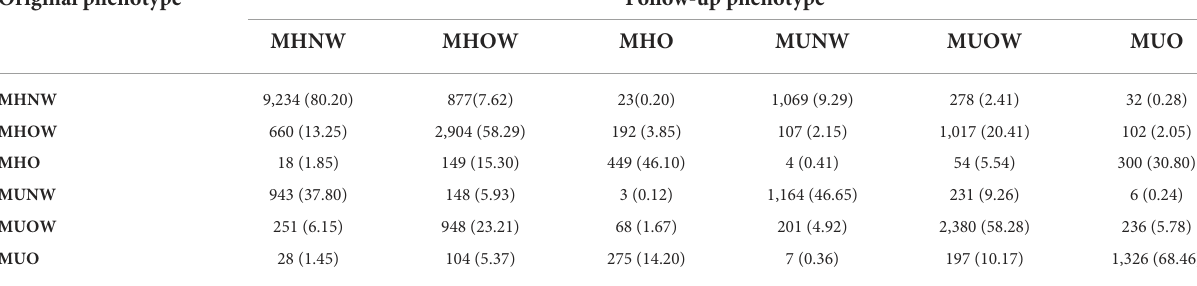
TABLE 3 The observed transition frequency during about 1 year in the study [ n